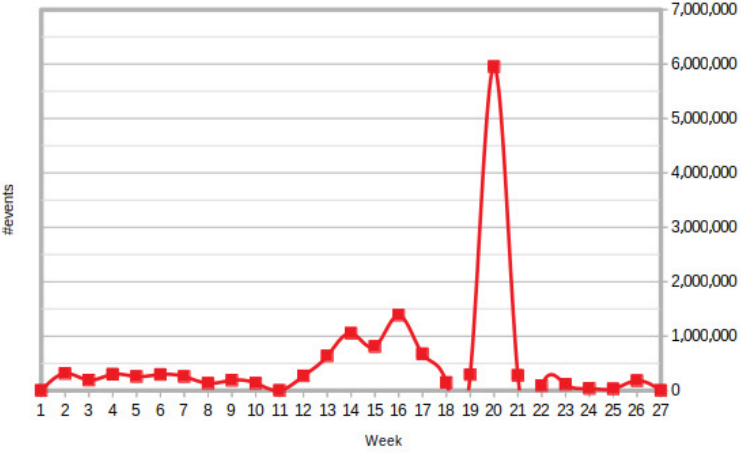
Figure 8. Monitoring infrastructure events flow per